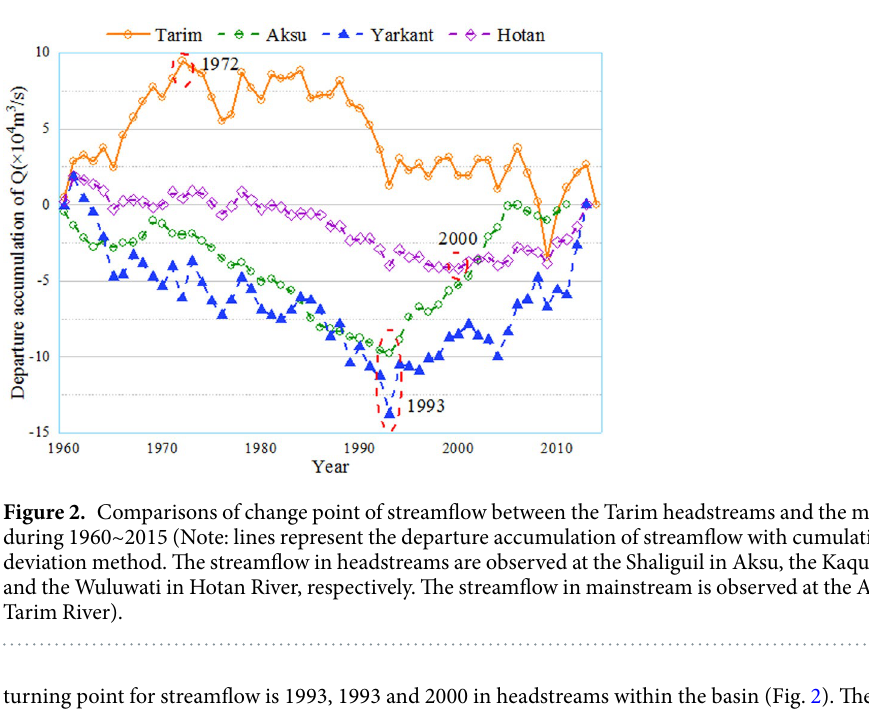
Table 2 lists estimation of change points for precipitation, annual potential evapotranspiration, and streamflow with the four methods. It can be seen that the four methods provide similar estimation for the change points. Streamflow alterations during the post impacted period were likely caused by human activities, such as irrigation and dam construction 11, 12 . During the post impacted period II, a warmer and wetter climate together with over exploitation of water resources in the TRB likely caused streamflow alterations 23 .